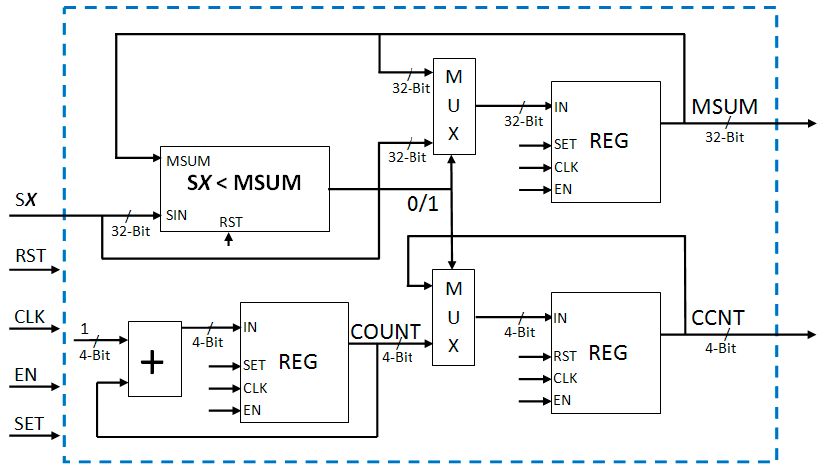
Figure 10. Internal architecture of minimum sum computation Stage-1 unit. S X → Sum Value of Xth Column in a Row; MSUM → Minimum Sum Value; CCNT → Column Counter; COUNT → Counter; MUX Multiplexer; REG Register.